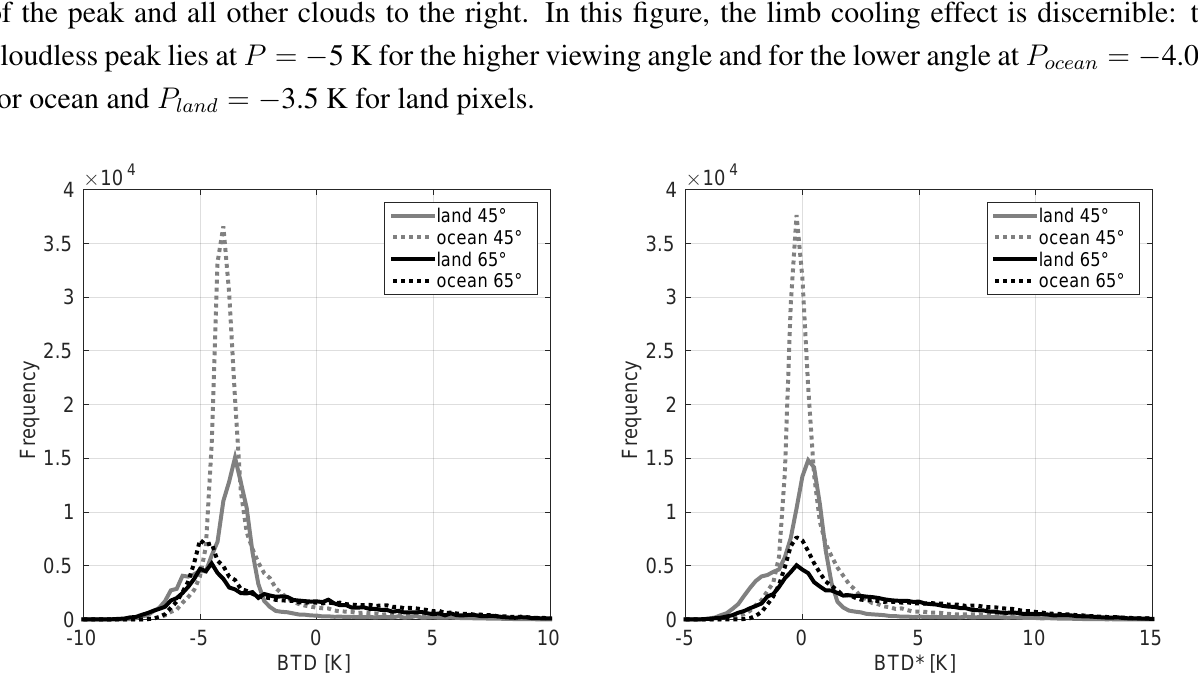
Figure 5. Frequency distributions of brightness temperature difference values (BTD) ( left ) and of viewing angle-corrected brightness temperature difference values ( BTD ∗ ) ( right ) for Europe, 11 January 2013, 0300 UTC. The histogram bin size is set to 0.25